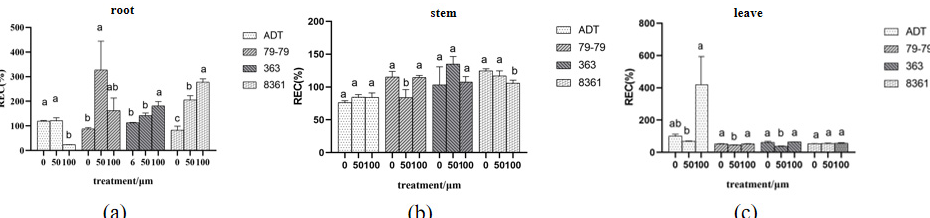
Figure 5. Relative conductivity of the roots, stems, and leaves treated with cadmium. Within each sunflower variety, the different letters indicate a significant difference at the p < 0.05 level, according to Duncan’s multiple range test. ( a ) is root, ( b ) is stem, ( c ) is leave. The water content in sunflower decreased after 10 and 15 days of cadmium treat- ment, and the water content in the roots and stems decreased more obviously than that of the leaves at 10 days (Figure 6c). Sun fl ower cultivar 79 − 79 treated with cadmium for 15 days showed better resistance in the roots, stems, and leaves than the other three cultivars (Figure 6d–f).